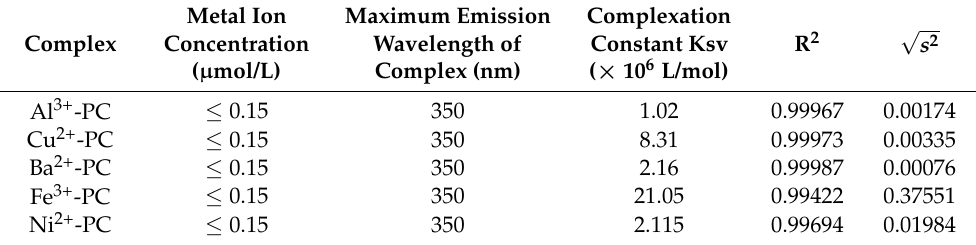
Table 1. Complexation constants (K sv ) for complexation between LOPC and metal